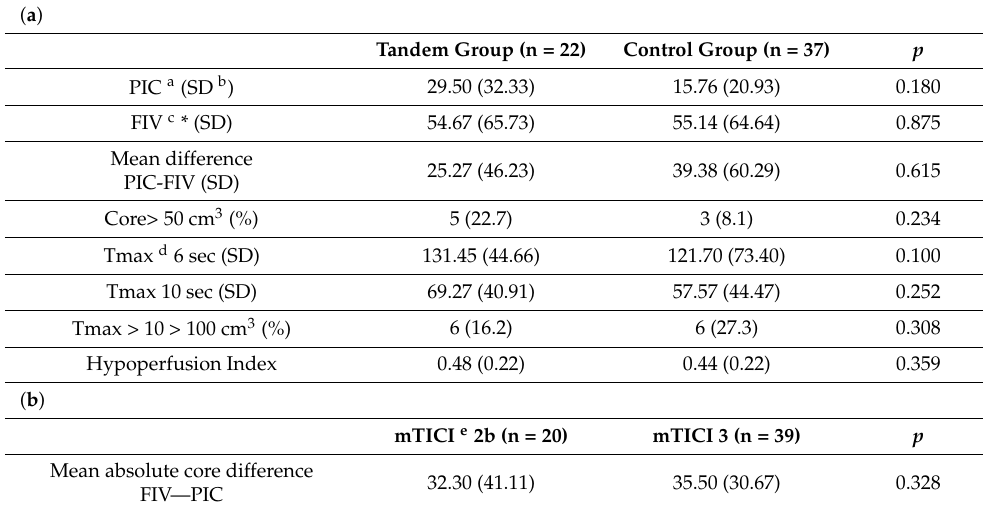
Table 3. Comparisons between groups for perfusional